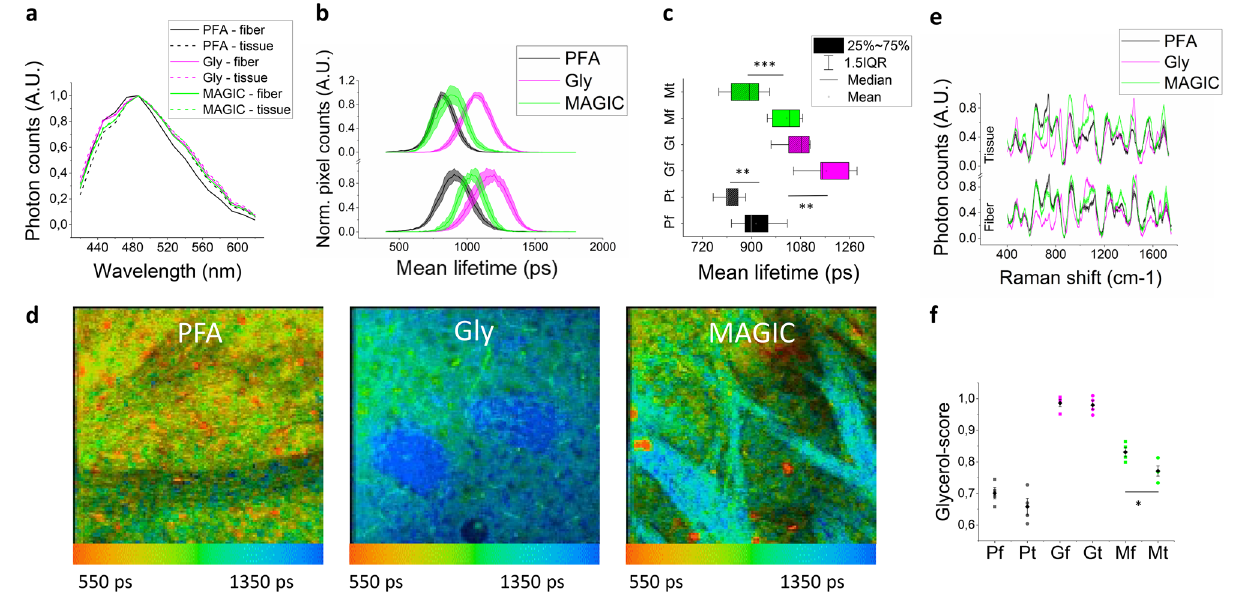
Figure 2. Characterization of the protocol. ( a ) Fluorescence emission spectra of the different samples excited with TPFM at 800 nm. ( b ) Fluorescence lifetime distributions (mean ± std.err) of fiber (bottom) and tissue (top) during the MAGIC steps. ( c ) Box chart plot of fluorescence lifetime values. ( d ) FLIM representative images during the three steps of the MAGIC protocol. Lifetime color scale is set from 550 to 1350 ps. ( e ) Raman spectra (mean ± std.err) of fiber and tissue during the MAGIC steps. ( f ) Glycerol scores (mean ± std.err) calculated along with the three major bands (550, 850, and 1465 cm -1 ) of the glycerol Raman spectrum. Statistical